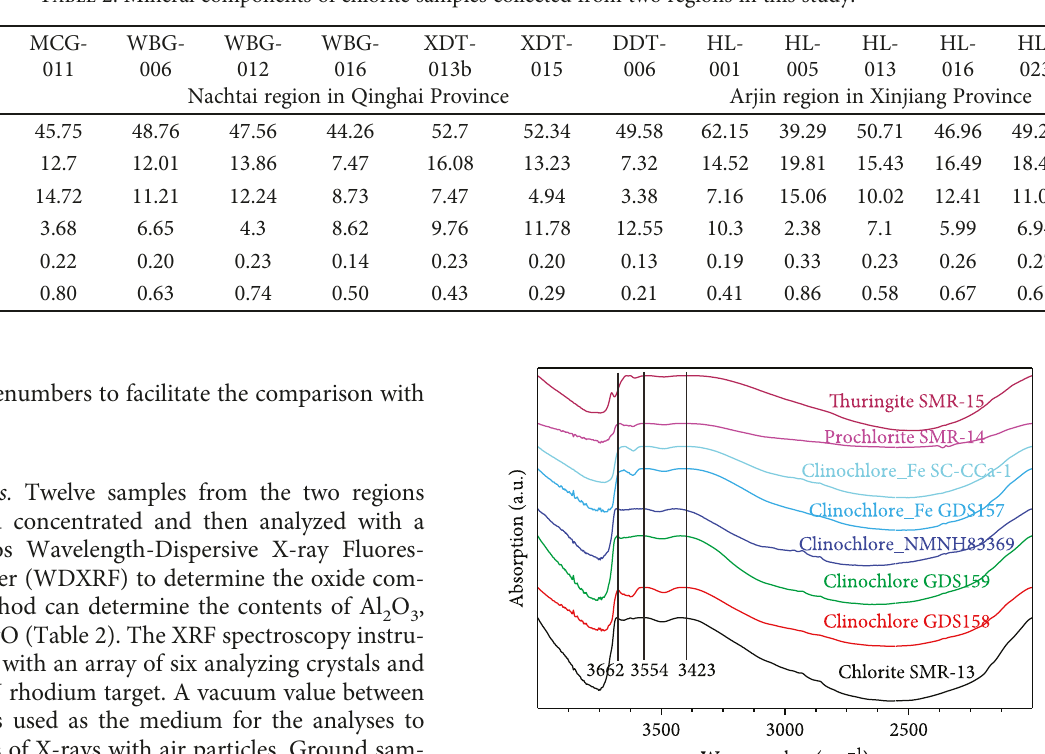
Figure 2: Infrared spectra of stretching vibrations of hydroxyl groups in the 2000 – 4000 cm − 1 spectral range obtained on the chlorite series in the USGS spectral library. The band positions of 3662, 3554, and 3423 cm − 1 are the average values from the IR spectra shown in this